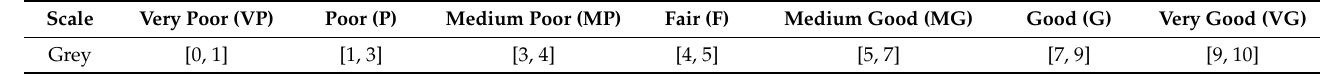
Table 8. The grey linguistic